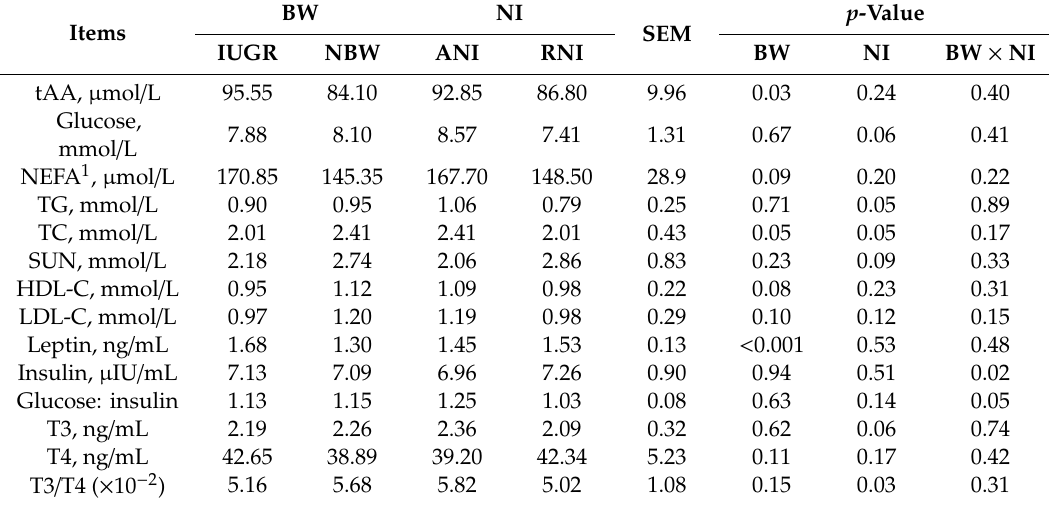
Table 3. E ff ects of the level of nutrient intake on serum metabolite concentrations of intrauterine growth-retarded (IUGR) and normal-birth weight (NBW)